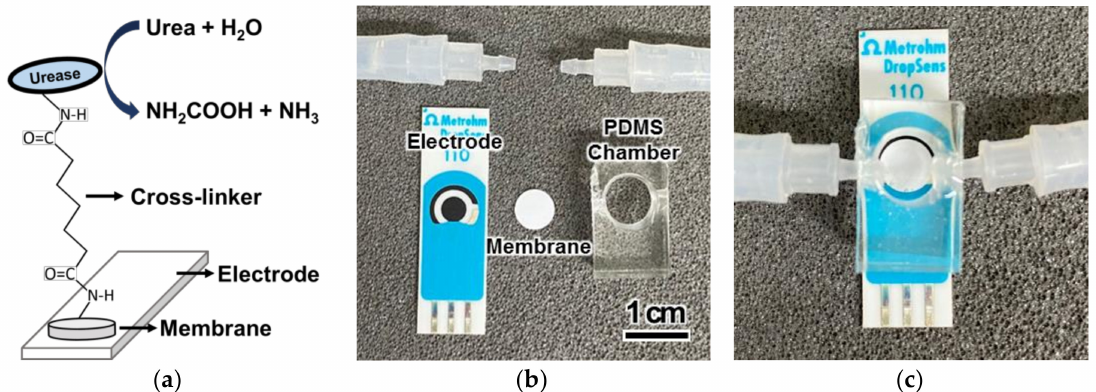
Figure 1. Schematic diagram of ( a ) the configuration of the urease-immobilized membrane; the configuration of the fluidic compartment of the urea biosensor ( b ) before and ( c ) after